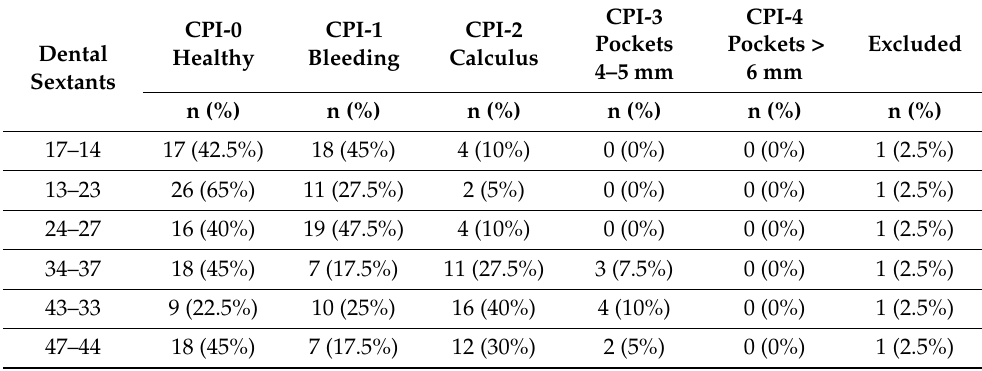
Table 2. An analysis of periodontal health based on the CPITN index—study group.